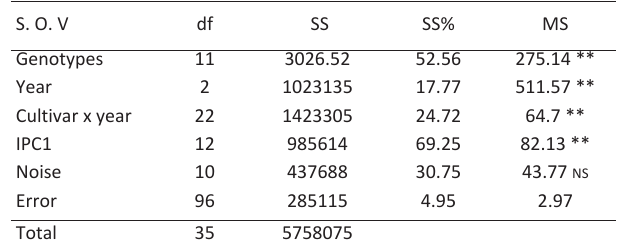
Table 6 - Analysis of variance for fruit yield of 12 olive cultivars by AMMi during 2006 -2008